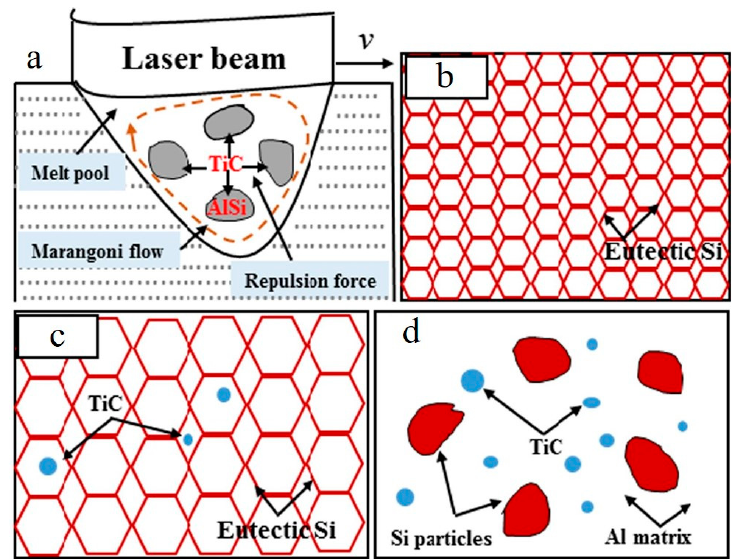
Figure 6. Microstructure evolution of the Al–15Si alloy reinforced with 1 wt.% ( a ), 2.5 wt.% ( b ), 7.5 wt.% ( c ) and 10 wt.% TiC ( d ) (reproduced with permission from [89]). Alternatively, the fabrication of AlSi10Mg/5 wt.%-nano-TiC [70] under an increased laser energy caused the nano-TiC particles to accumulate in clusters, forming the micron- sized agglomerates. However, the dispersion of reinforcement became more uniform, as shown in Figure 7a–d.